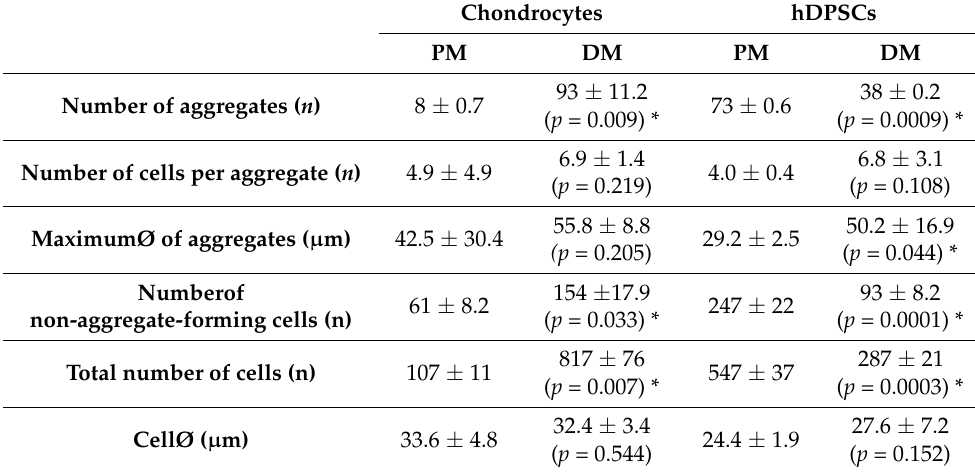
Table 3. Morphometric analysis of cell aggregates in alginate-agarose scaffolds. Chondrocytes hDPSCs PM